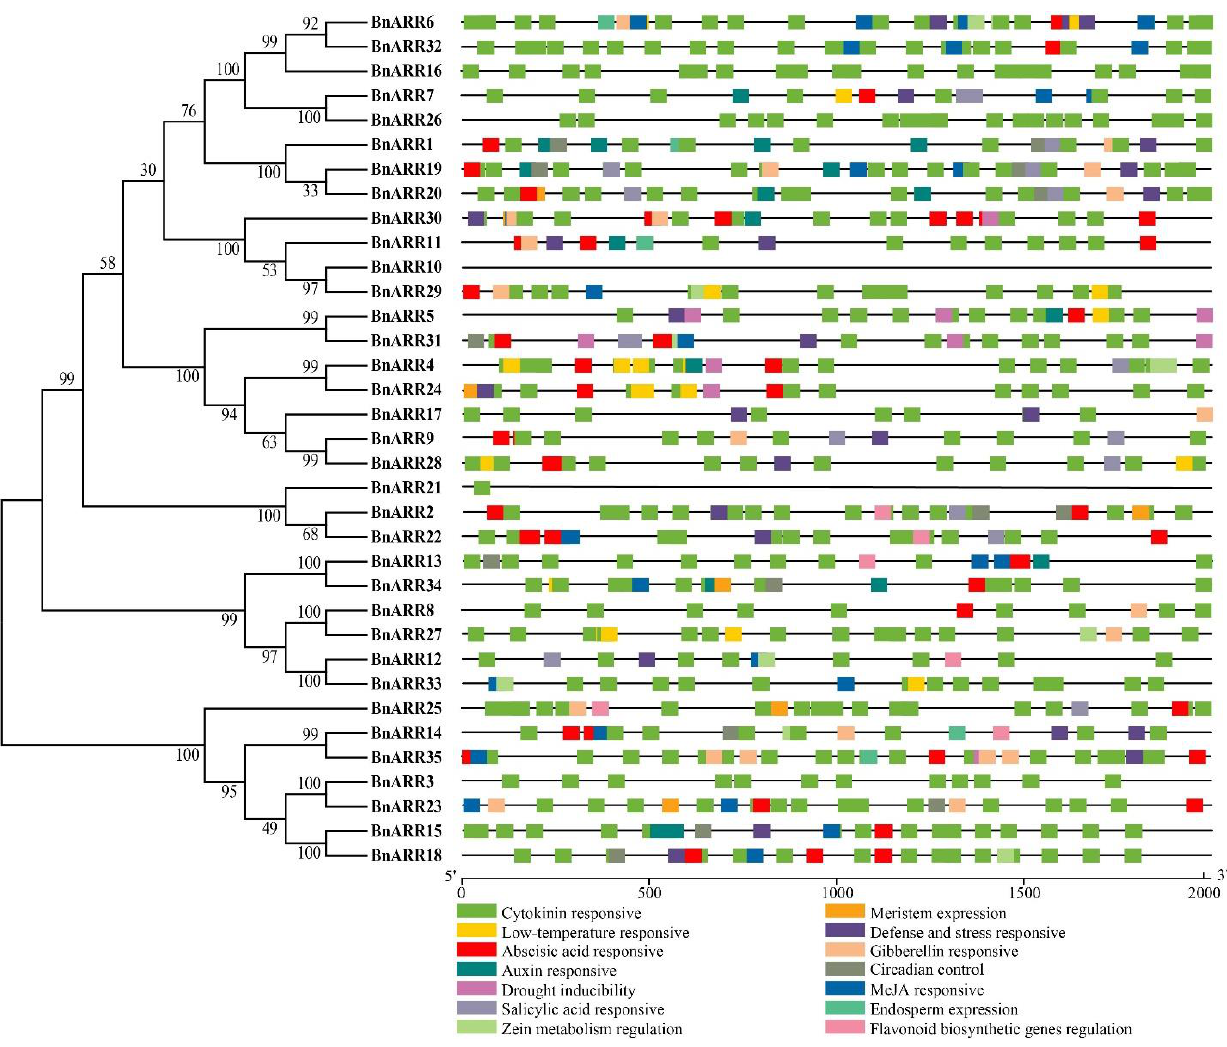
Figure 9. Cis -acting elements in the type-B BnARR promoters.